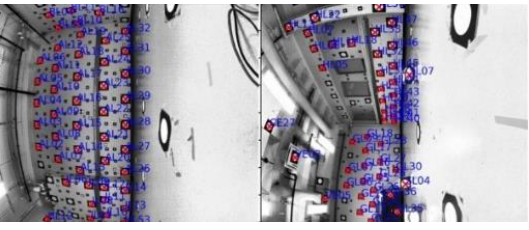
Figure 3. Example of Ladybug5 imagery with measured targets.